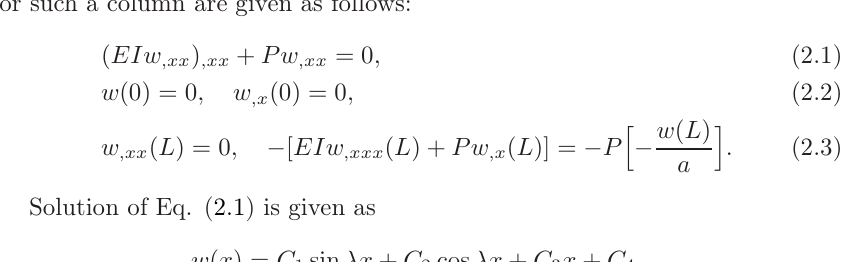
Figure 1. Tilt-buckled